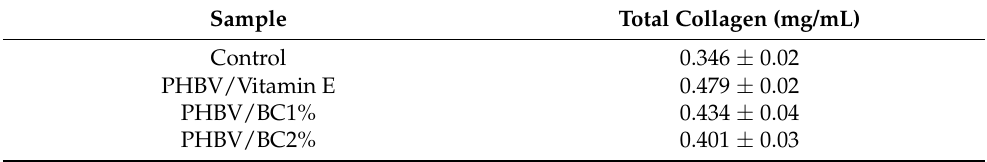
Table 5. Total soluble collagen secreted by mouse NCTC fibroblasts in the presence of the biocompos- ite materials for 5 Table 4. Cell cycle distribution (%) of mouse NCTC fibroblasts treated with PHBV/BC-based biocomposites.